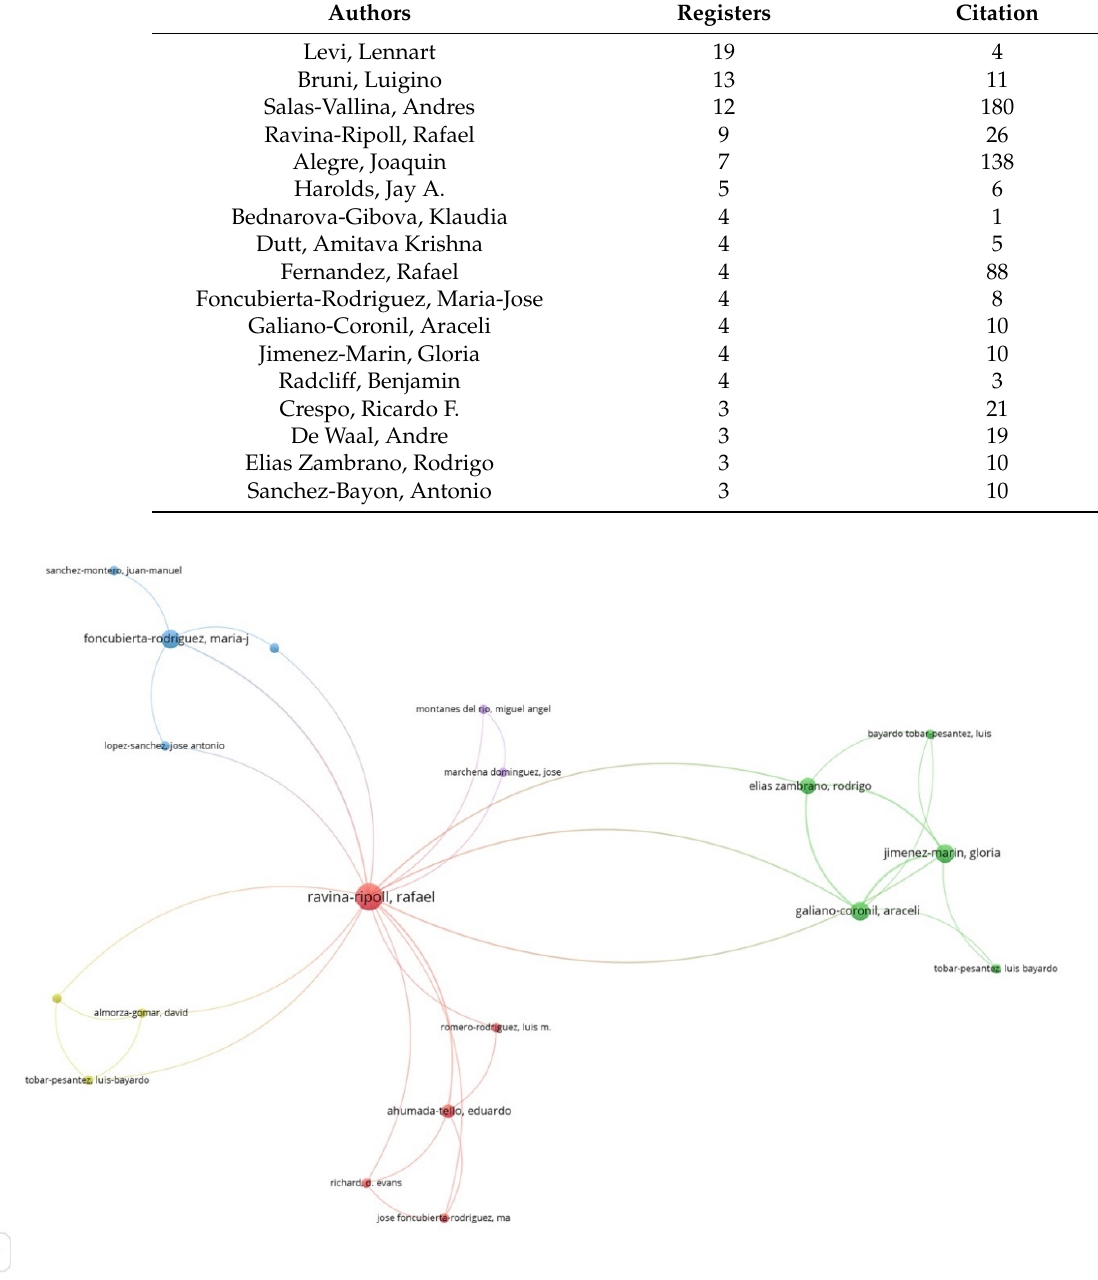
Table 3. Ranking of authors with the highest numbers of registers and citations.